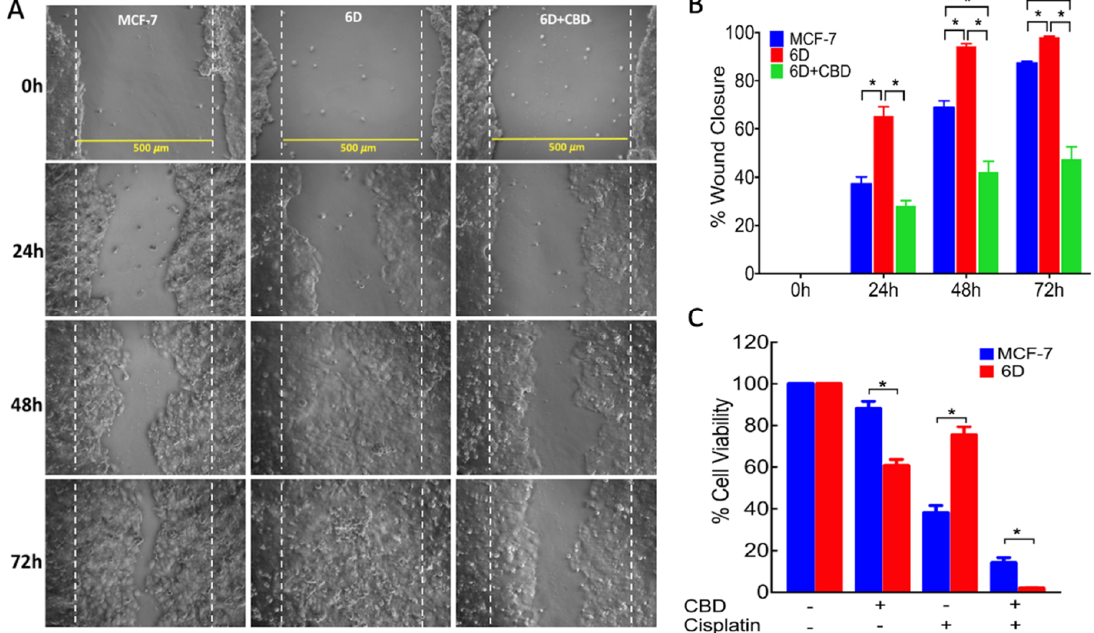
Figure 2. Cell migration and cell viability assays. The MCF-7 and 6D cells were cultured to 90% confluence and wounded to obtain a clear area of 500 µm flanked by dotted parallel lines. After making the wound, a set of 6D cells was treated with 10 µM CBD. ( A ) Closure of the wound was registered every 24 h by phase contrast microscopy until 72 h. ( B ) The percentage of wound closure was measured in all the experimental conditions by image analysis and represent the average of three independent batches of cells (biological replicates) were each examined in quadruplicate (assay replication, n = 12). ( C ) Resistance to 100 µM cisplatin was evaluated by cell viability assays. Data from three independent experiments are presented as percentage of viable 6D cells relative to control MCF-7 cells ( n = 9). Asterisks indicate significance at p < 0.05.